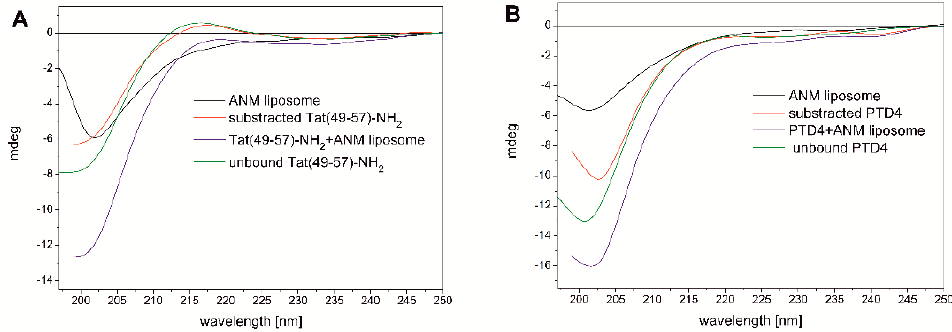
Figure 2. CD spectra showing the conformational behavior of Tat(49–57)-NH 2 ( A ) and PTD4 ( B ) peptides during their interaction with ANM liposomes. ( B ) peptides during their interaction with ANM